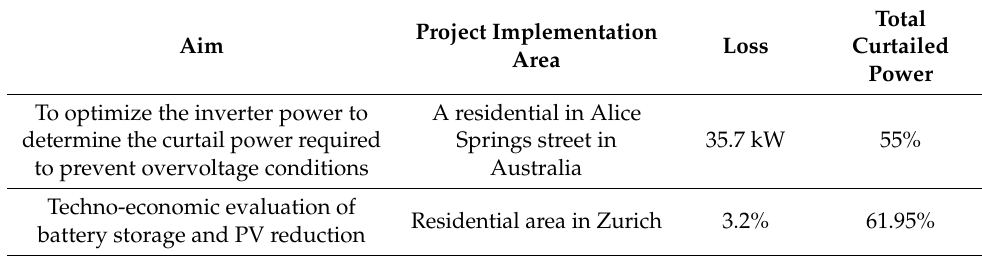
Table 5. Summary of different PVGC methods.